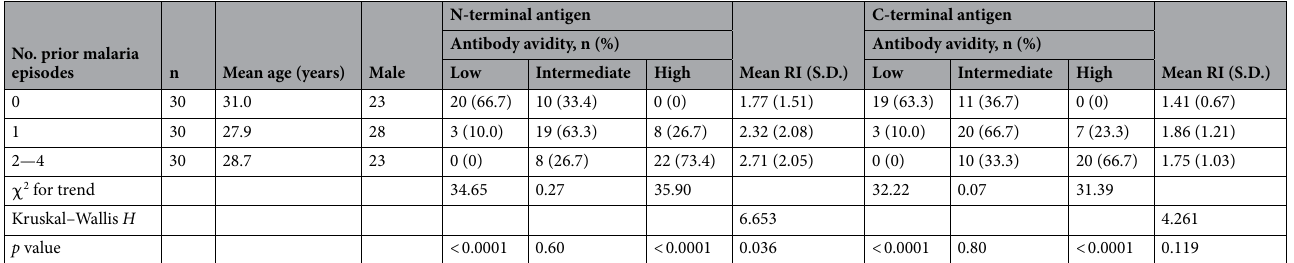
Table 5. Distribution of antibody avidity and reactivity indices (RI) to the N- and the C-terminal antigens of PvMSP9 and previous malaria